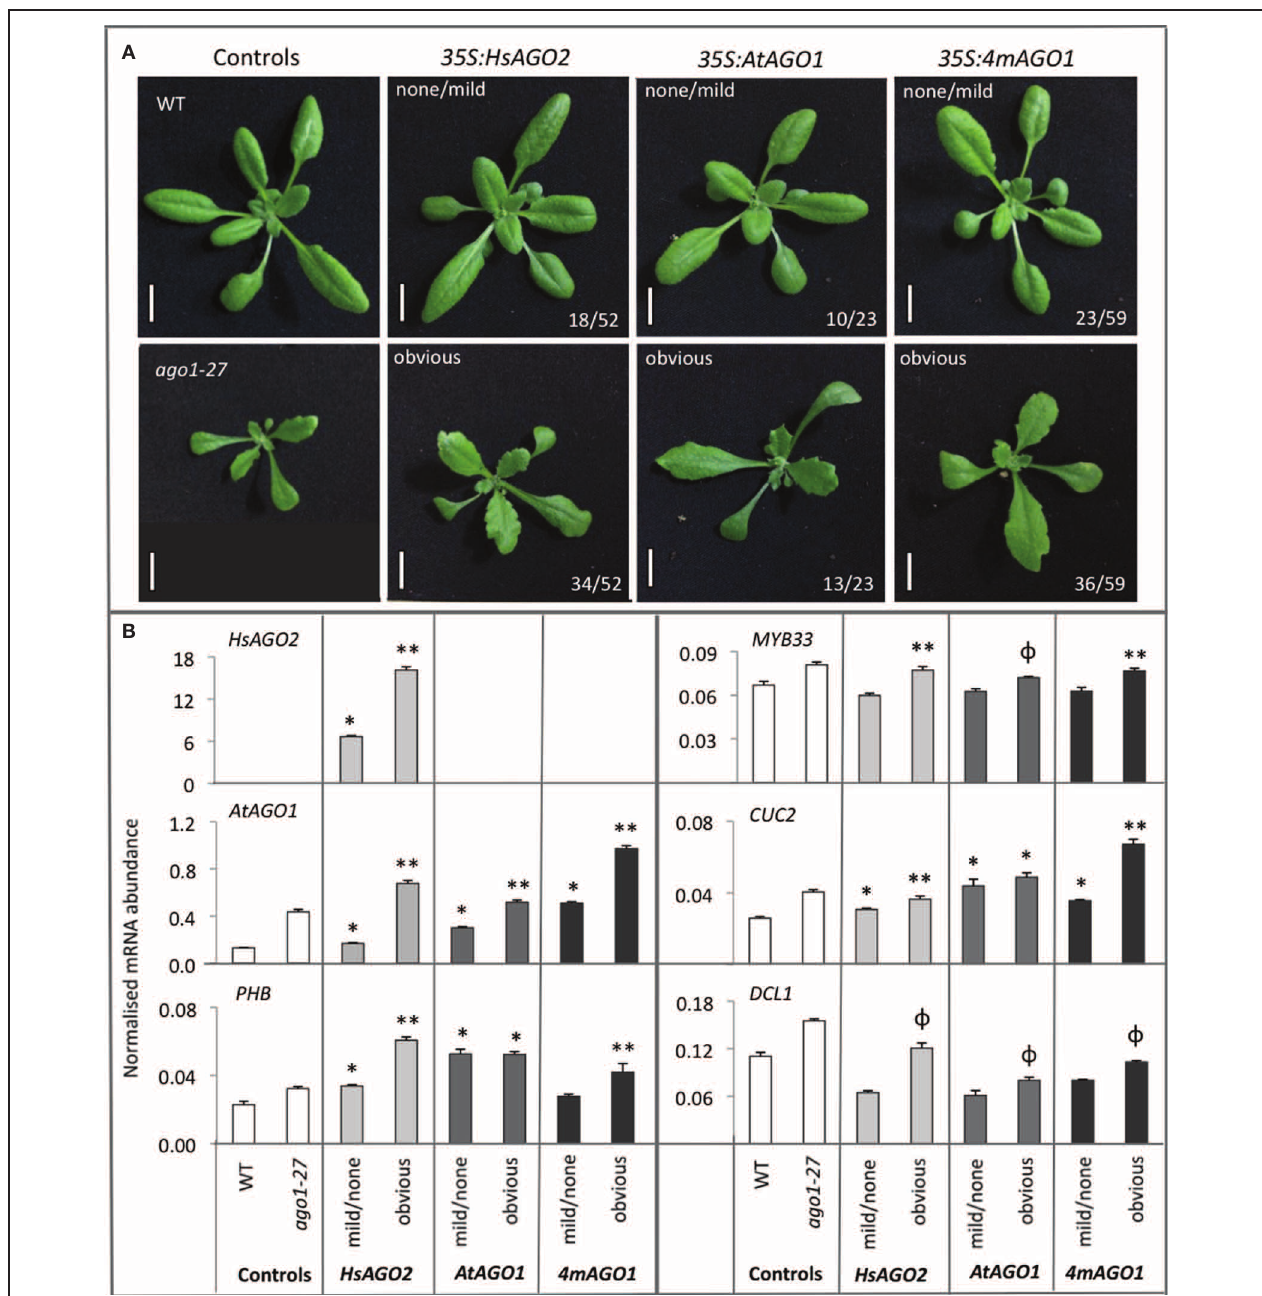
FIGURE 2 | Overexpression of HsAGO2 or AtAGO1 results in similar morphological and molecular phenotypes. (A) 24-day old primary transformants for the 35S:HsAGO2 , 35S:AtAGO1, and 35S:4mAGO1 constructs, grown in parallel, were categorized as exhibiting an obvious abnormal morphological phenotype, characterized by broad, flattened, serrated leaves, or no/mild abnormal phenotype. Wild type (WT) and ago1–27 plants were grown in parallel as comparators. Scale bars represent 10mm. (B) The abundances of HsAGO2 mRNA and un-cleaved mRNA for AtAGO1, PHB, MYB33 , CUC2, and DCL1 were measured in total RNA from sample pools composed of 4–8 transformants, 24-days old, from each morphological category for each construct. Wild type (WT) and ago1–27